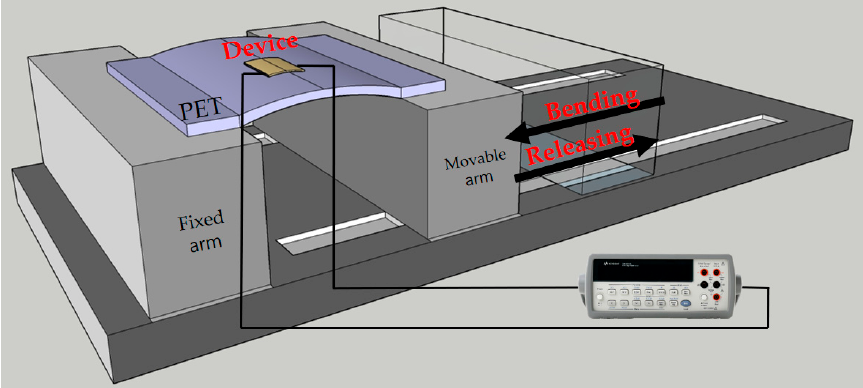
Figure 2. Schematic of the bending machine used to measure the output voltages in this work which is connected to a Keysight Technologies 34401A.